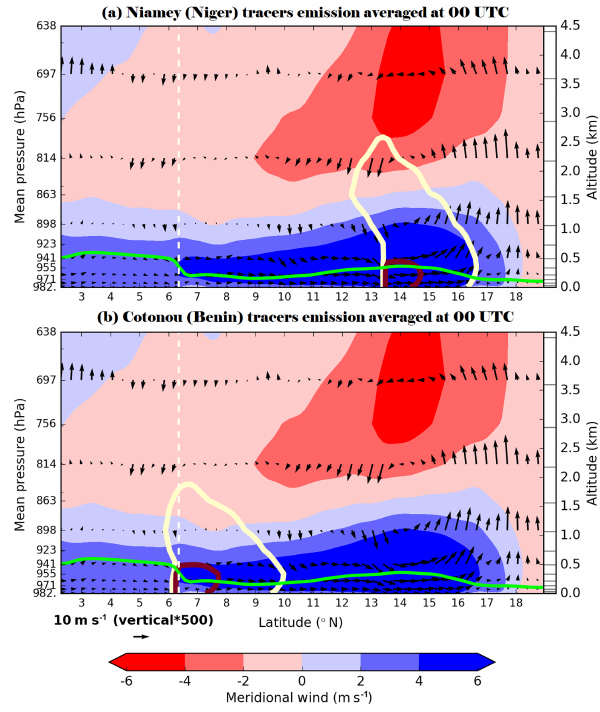
Figure 8. Vertical cross section of the meridional wind (shading in ms − 1 ) along a meridional transect from 2 to 19 ◦ N, averaged from 2 to 3 ◦ E including Cotonou (Benin) and Niamey (Niger) and averaged over 20 to 30 June at 00:00UTC. Isocontours repre- sent gaseous tracer concentration continuously emitted (in arbitrary units) from the 1 to 30 June at (a) Niamey (Niger) and (b) Cotonou (Benin). Brown and yellow shading represents tracer concentration of 1a.u. and 10%a.u., respectively. The green line is the PBL height (m). Vectors represent the wind field in the plan of the transect (with an aspect ratio of 500 between the meridional and the vertical com- ponents). The white vertical dash line is the latitude of the